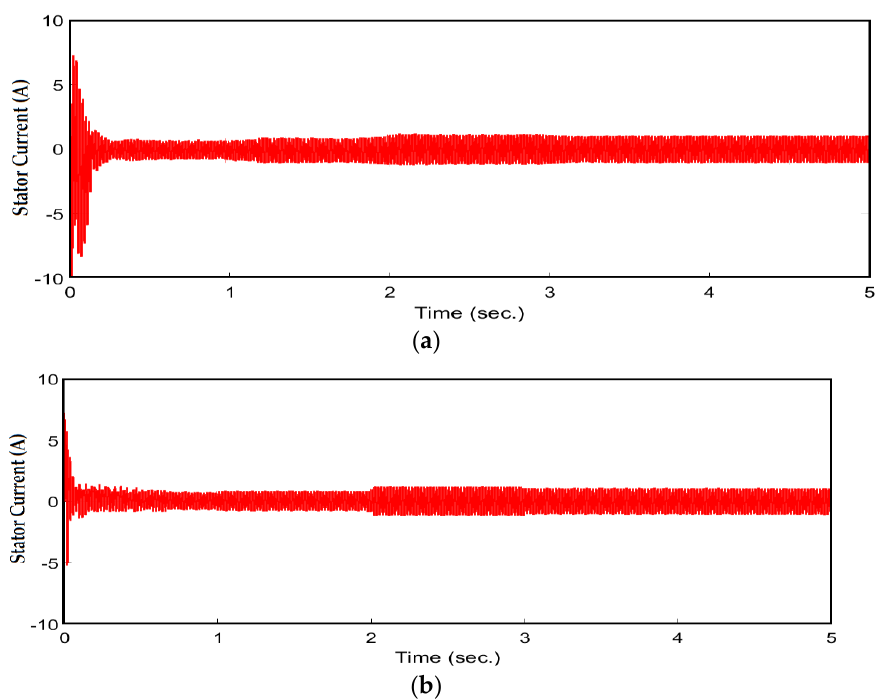
Figure 22. The Stator current for the desired speed, 50 rad/s, for ( a ) fuzzy PID based PSO and ( b ) fuzzy-PID-based